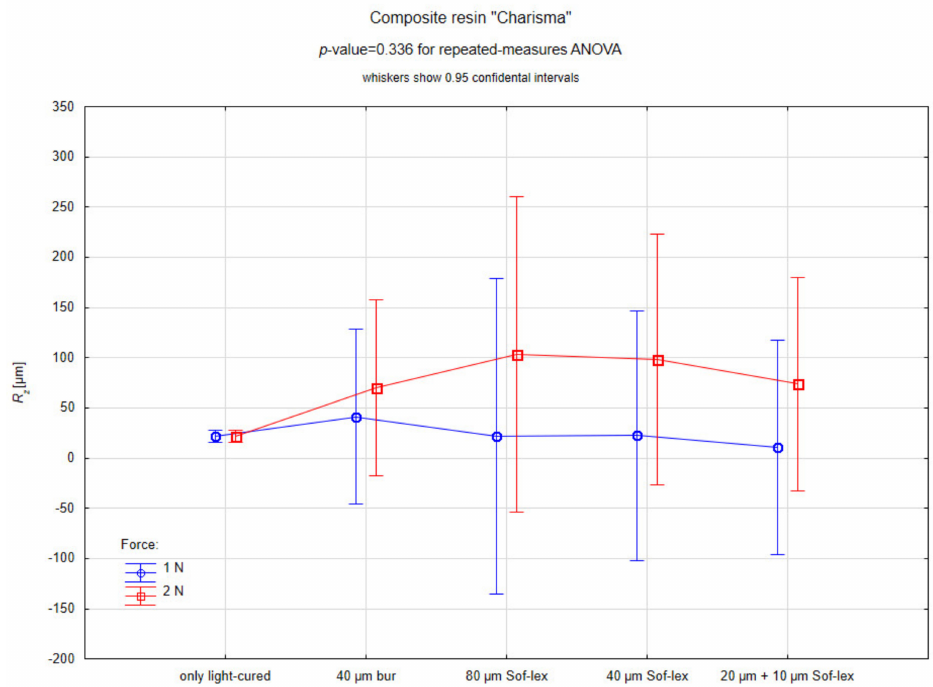
Figure 4. Repeated-measures analysis of variance for R z values in the individual polishing steps depending on the press-on force for Charisma samples.